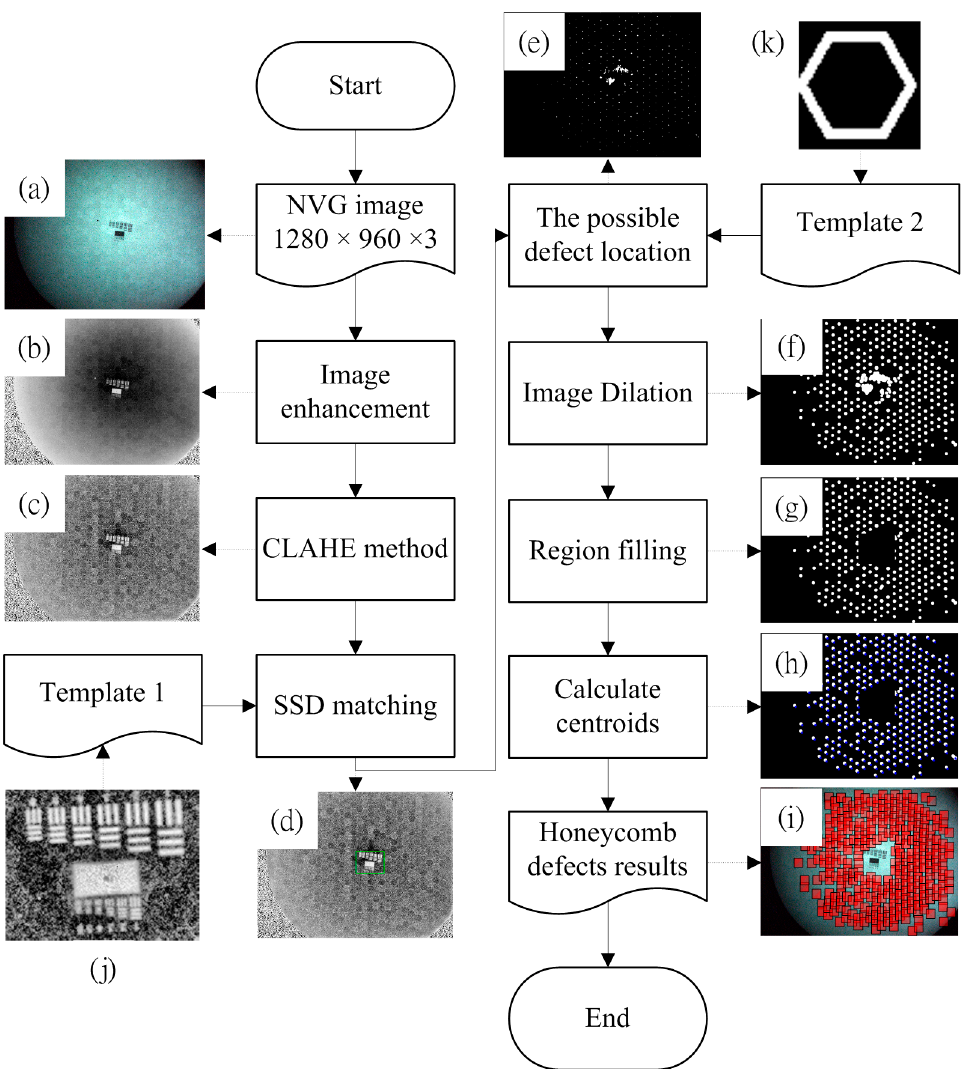
Figure 5. ( a – k ) Automatic honeycomb defect detection process.